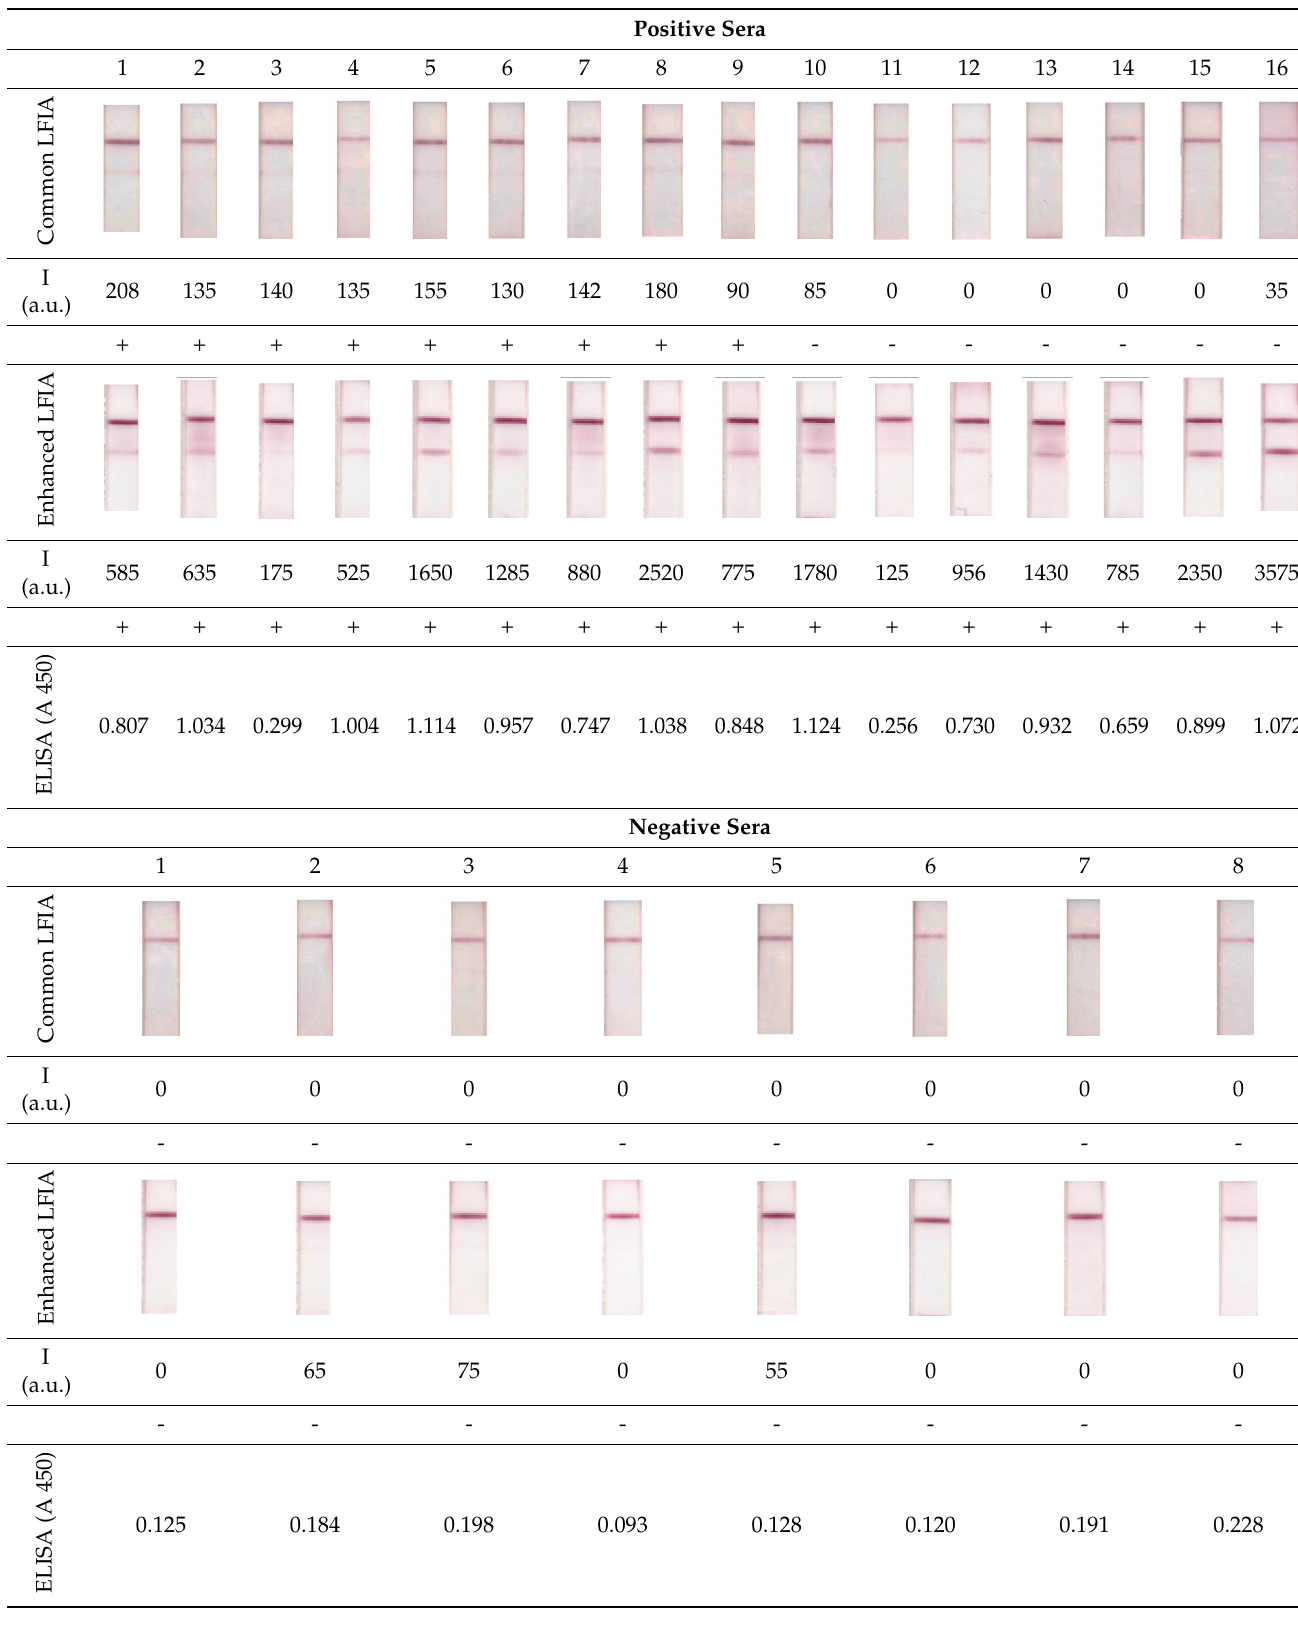
Table 1. Comparison of ELISA and LFIA data for 24 human serum